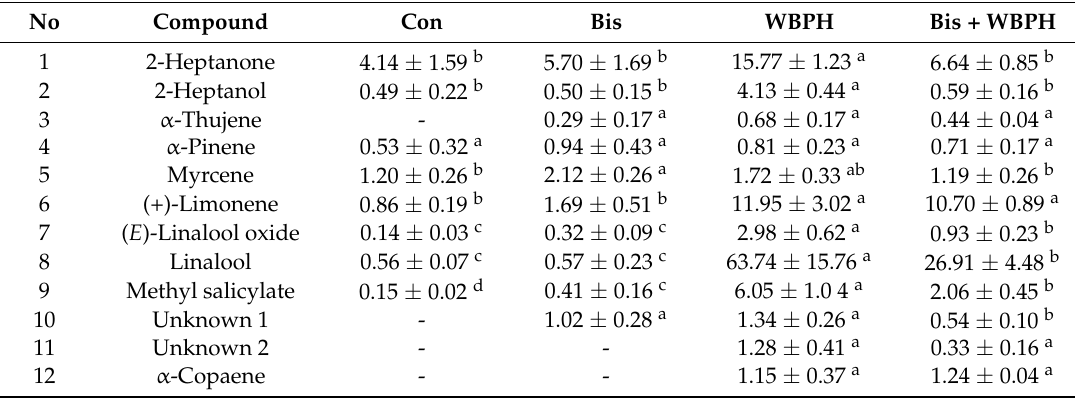
Table 1. Comparison of volatile compounds (mean ± SE, n = 6) emitted from control plants, bismerthiazol-treated plants, WBPH-infested plants and bismerthiazol + WBPH plants. These treatment methods were described in the section of Materials and